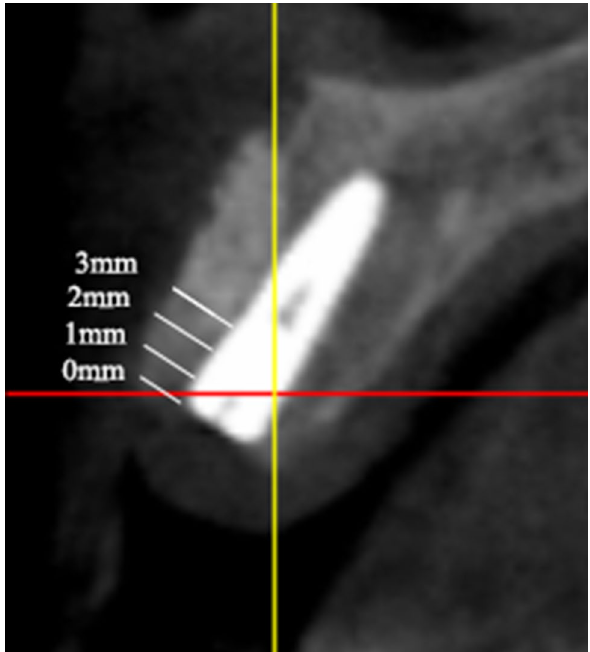
Figure 3. Measurement of bone widths at all four different levels (below the implant neck platform to 0 mm, 1 mm, 2 mm, and 3 mm).